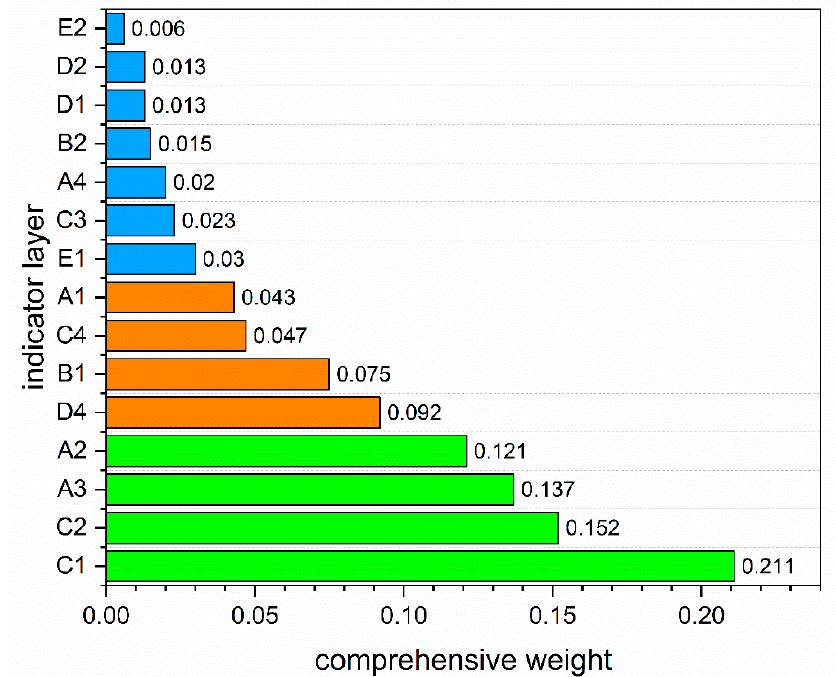
Figure 3. Ranking of the weighting of the indicators.